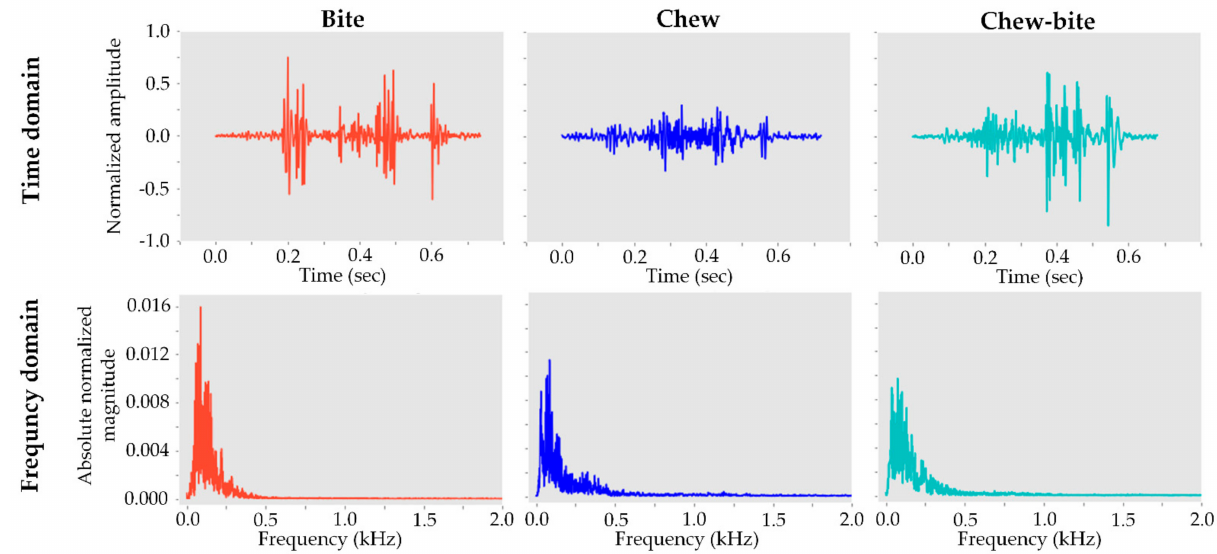
Figure 2. Sample illustrations of acoustic signals in time ( top ) and frequency ( bottom ) domains for the ingestive sounds. Higher absolute normalized values indicate higher power of the acoustic